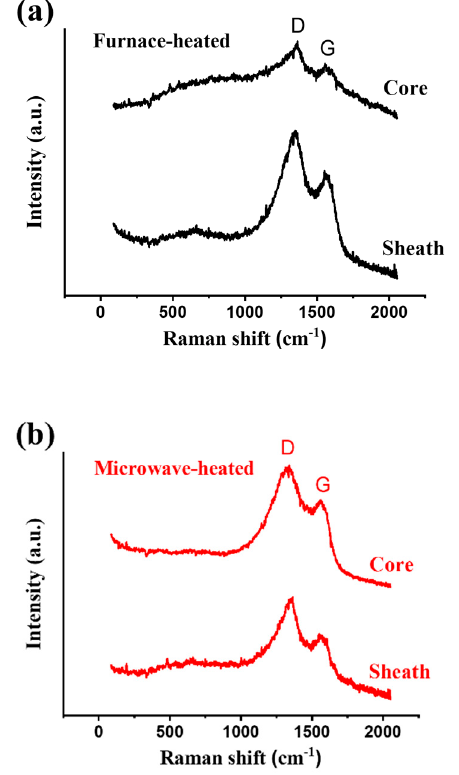
Figure 10. The Raman spectra of ( a ) furnace-heated and ( b ) microwave-heated specimens. Table 3. The sheath-core factor of furnace-heated and microwave-heated specimens.